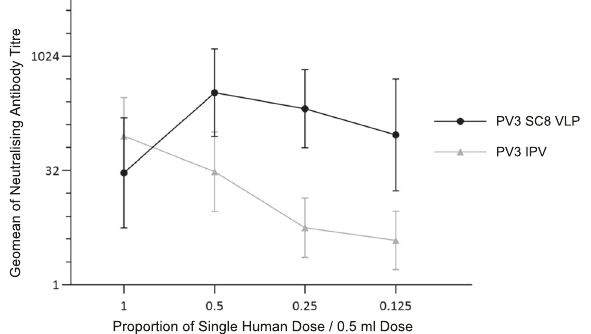
Fig. 7 Immunogenicity of stabilised PV3 SC8 VLPs in Rats. Geometric mean neutralising antibody titres of sera from rats inoculated with a dilution series of PV3 SC8 VLPs or IPV. Bars indicate geometric standard deviation.